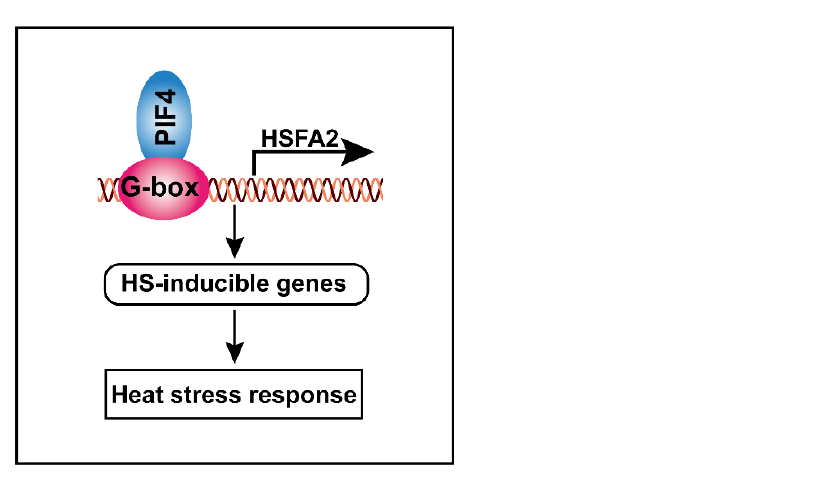
Figure 9. Schematic model showing how PIF4 modulates the heat stress response in plants. PIF4 directly binds to the G-box motifs to promote HSFA2 gene expression, thereby resulting in the activation of the HS-inducible genes. These leads to a stronger basal thermotolerance under non-heat-treatment conditions, thereby resulting in enhanced tolerance to severe heat stress.